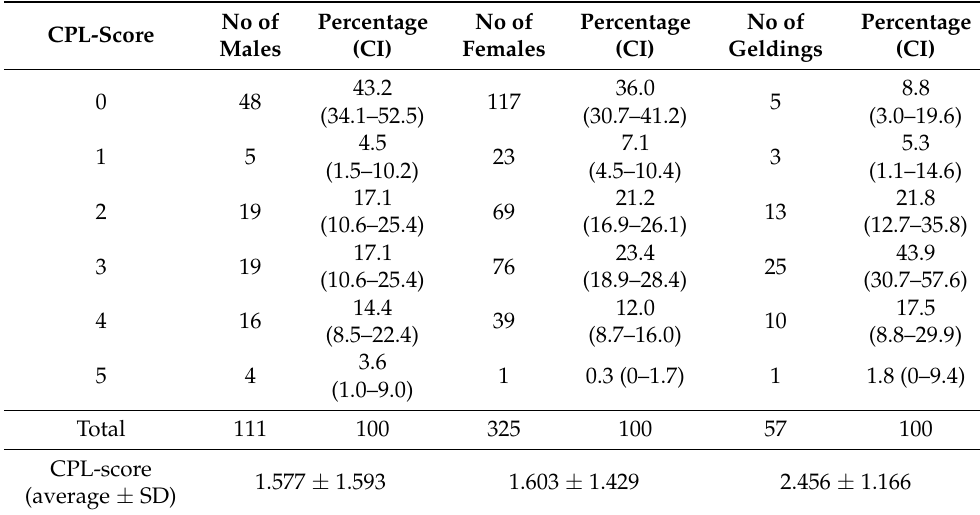
Table 3. Numbers and percentages with 95% confidence intervals (CI) of males, females and geldings by chronic progressive lymphedema scores in 493 Rhenish German draught